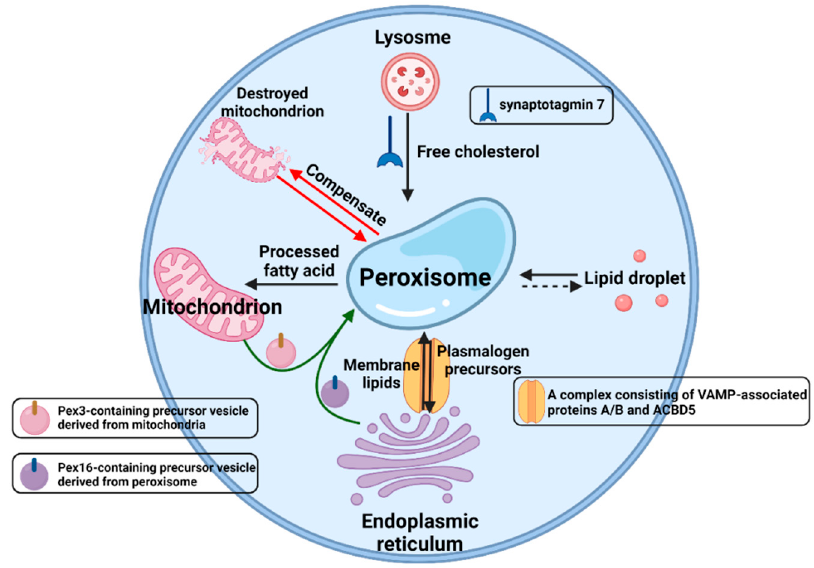
Figure 6. Interactions of peroxisomes with other intracellular organelles.